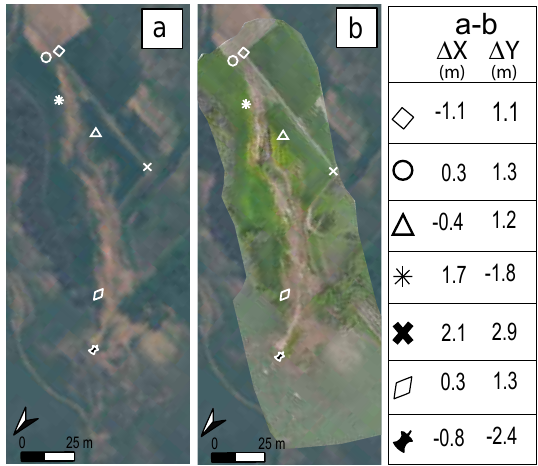
Figure 3. Position of the seven GCPs used to evaluate the co- registration of WorldView-2 satellite image (a) and UAV image (b) . Corresponding points are illustrated with the same symbol. Differ- ences of the coordinates of the corresponding points along X (E–W direction, (cid:49)X ) and along Y (N–S direction, (cid:49)Y ) are provided in metres on the left of the